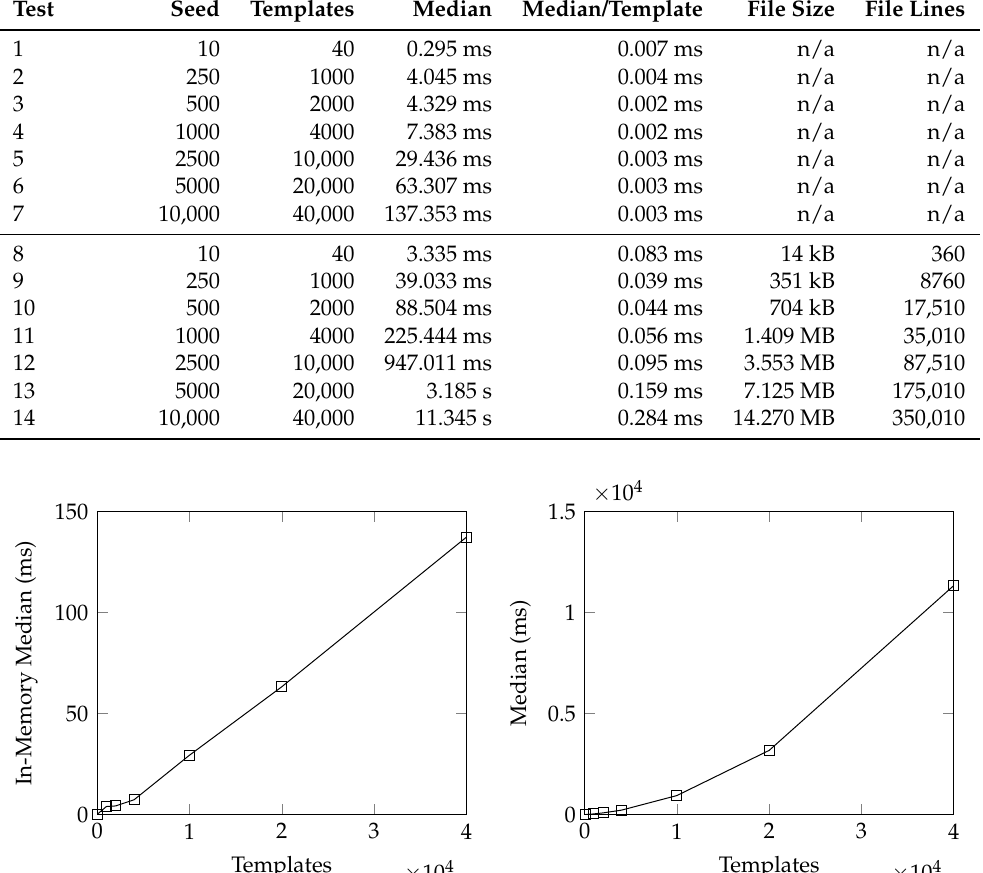
Table 1. Benchmark results of the Variability Resolver prototype (Since tests 1–7 are in-memory, respective file measurements are not available).